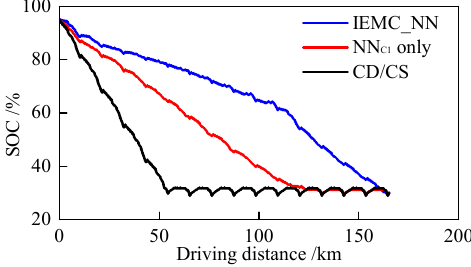
Figure 15. Battery SOC variation under a normal driving distance (NEDC, 165